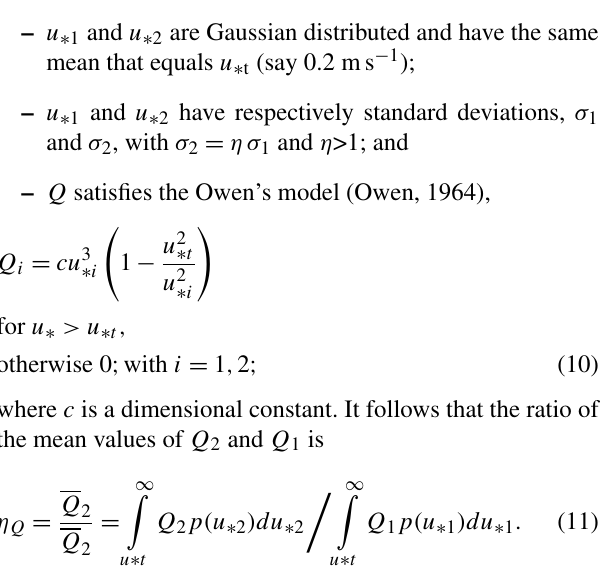
Figure 8. The probability density functions of u ∗ and w ∗ , p(u ∗ ) and p(w ∗ ) for Event-10 and Event-11, together with the Gaus- sian approximations for the p(u ∗ ) functions. The mean values (m) and standard deviations (SD) for the Gaussian (G) distributions are given. Note that for p(w ∗ ), 3 p(w ∗ ) against w ∗ / 3 is plotted to con- veniently present the information in the same